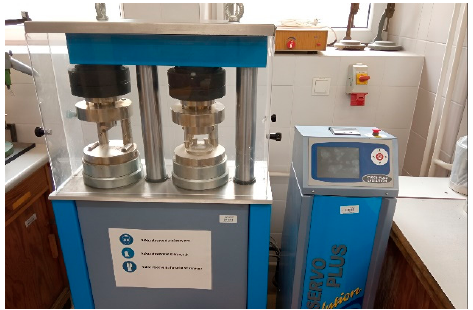
Figure 6. Matest model E—183PN100 (photo by K. Se ń czuk).